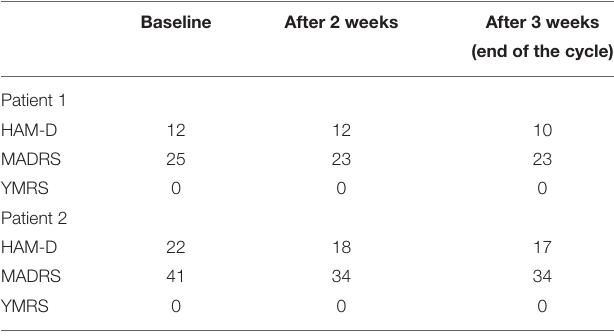
TABLE 1 | Clinical rating scales at baseline, after 2 weeks and after 3 weeks (end of the cycle). Baseline After 2 weeks After 3 weeks